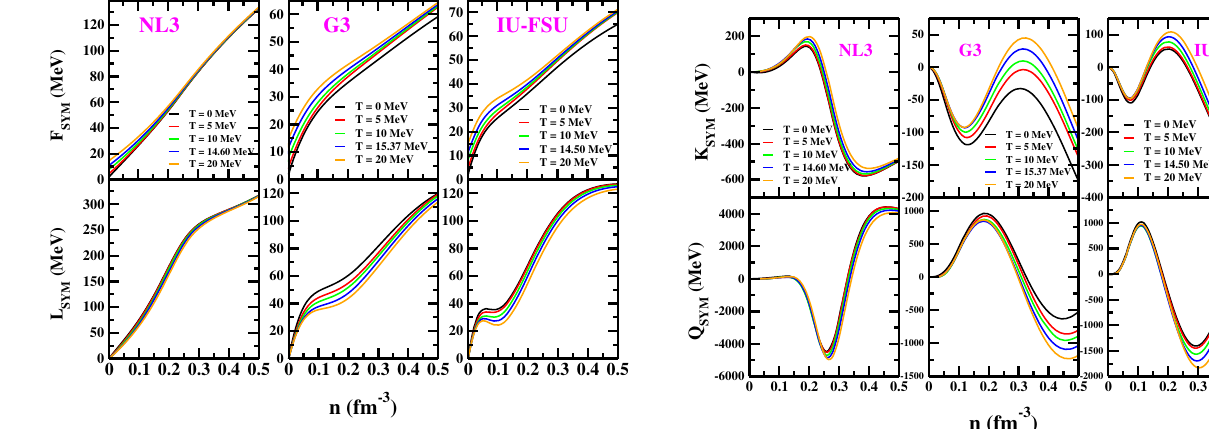
Fig. 6 K sym and Q sym as a function of nucleon density for SNM ( t = 0). The left panel shows the results for NL3 and right panel for G3 parameter set